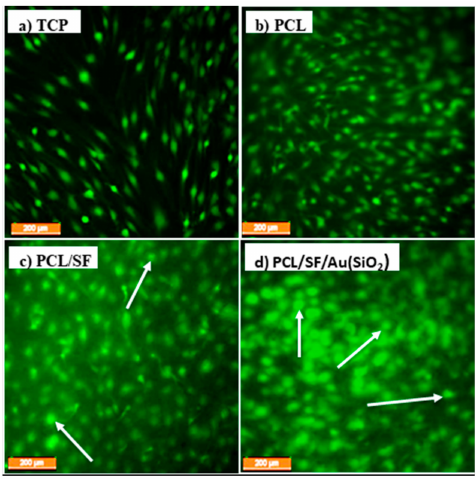
Figure 7. CMFDA dye extrusion image to analyze the cell morphology on ( a ) TCP, ( b ) PCL, ( c ) PCL / SF. and ( d ) PCL / SF / Au(SiO 2 ) nanofibrous sca ff olds at 10 × magnifications (Scale bar: 200 µ m). Arrows indicate the osteoblast-like morphology of the di ff erentiated hMSCs.